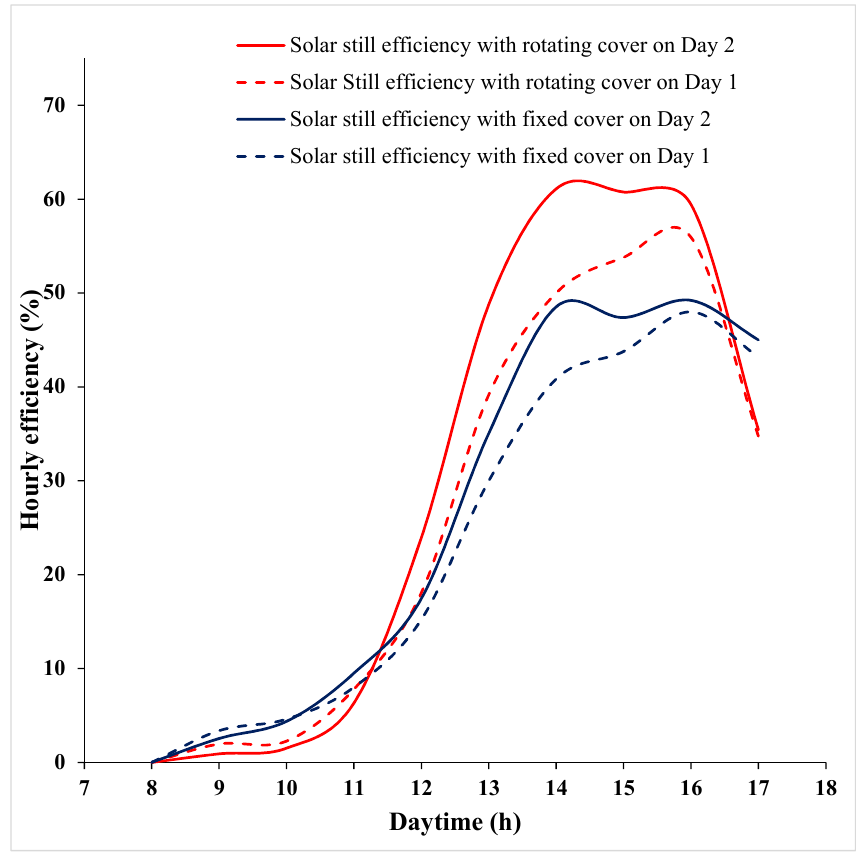
Figure 9. Solar still efficiency for 27 August (day 1) and 28 August (day 2) 2021, where the cylindrical cover is fixed or rotates.